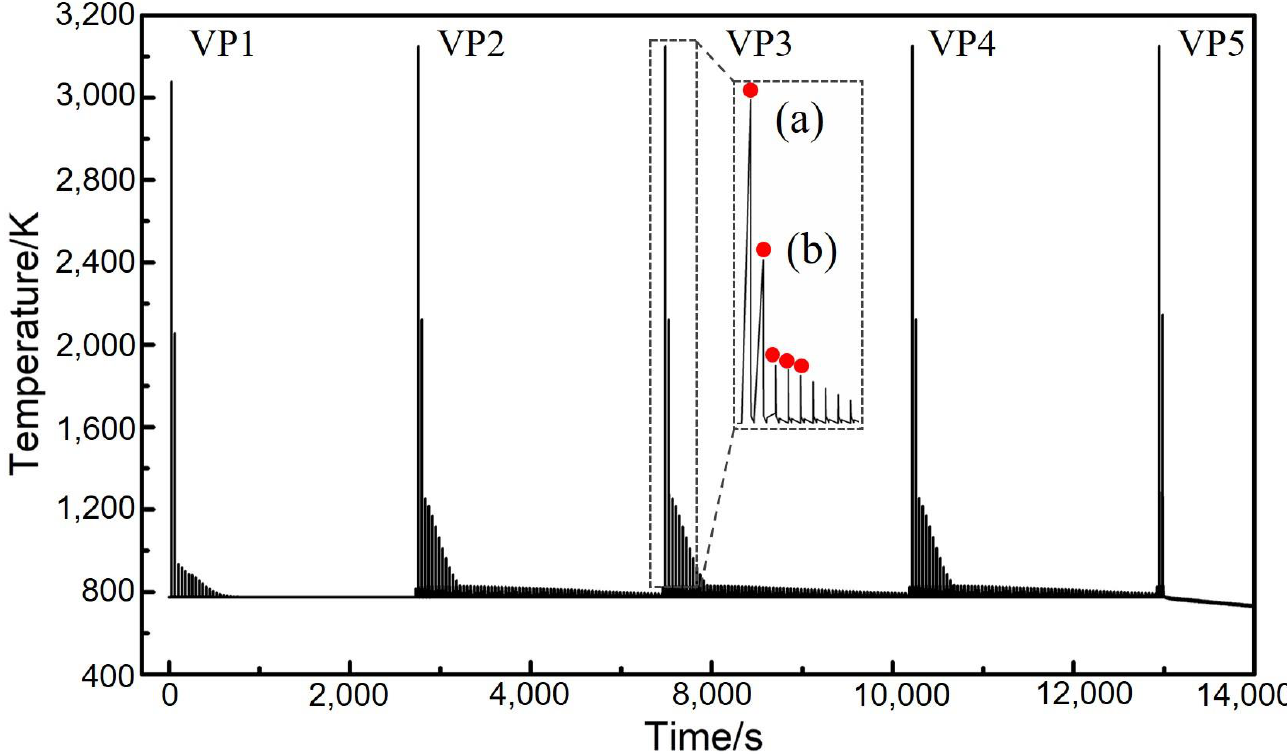
Figure 3. Evolution of temperature at the five vertical sampling points (VP1, VP2, VP3, VP4 and VP5) with time. (Zone ( a ) illustrates the thermal history of the active layer during melting and cooling, and zone ( b ) illustrates the influence of the subsequent processes on the temperature history of the current layer.).